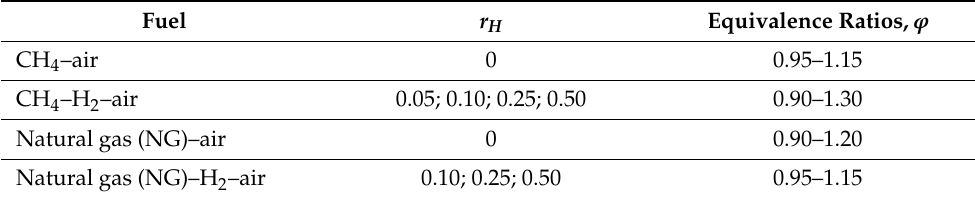
Table 2. Studied systems (fraction of H 2 , r H , and equivalence ratios, ϕ ). Fuel r H Equivalence Ratios,